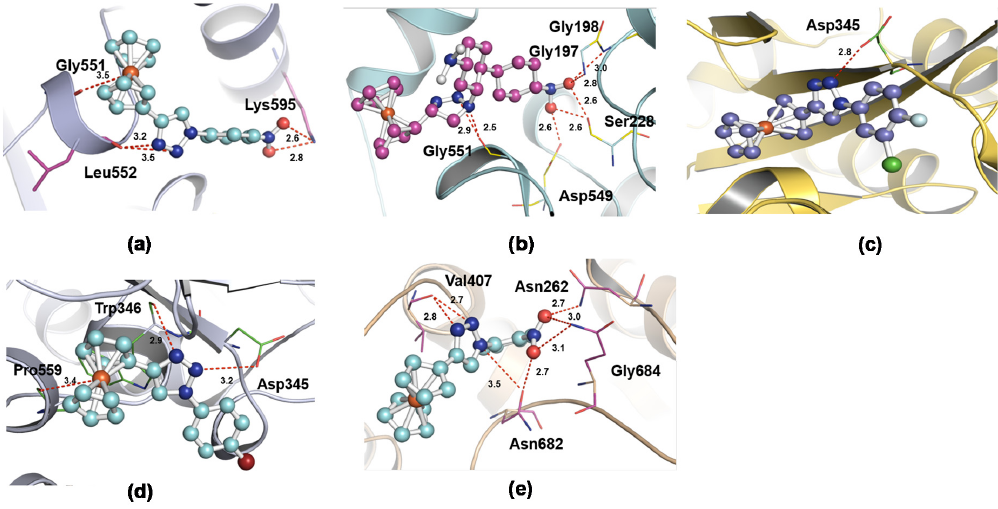
Figure 8. Molecular docking of hybrid compounds X1 ( a ), X2 ( b ), X3 ( c ), X4 ( d ), and X5 ( e ) with cPLA 2 (PDB code: 1CJY).